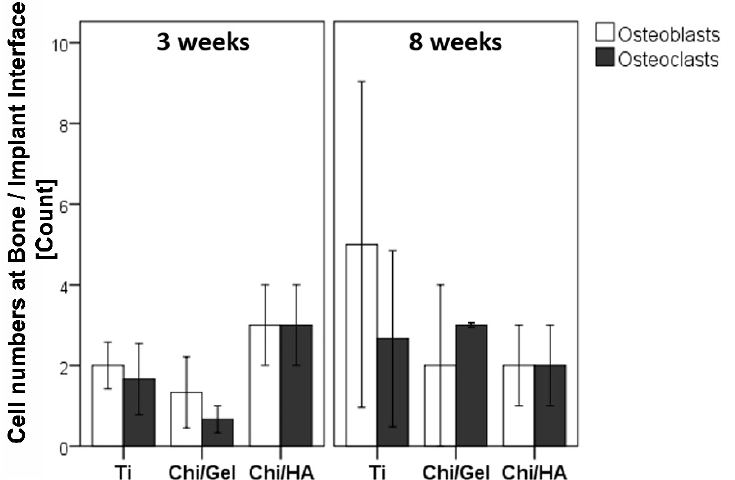
Figure 2. Quantitative evaluation of osteoblasts and osteoclasts within bone-implant interface showed higher osteoblasts/osteoclasts count in Ti and Chi/Gel groups after 8 W. Bone remodeling is governed by balanced osteoblast and osteoclast activity. Therefore, osteoblasts and osteoclasts were quantitatively evaluated for all groups. Higher osteoblasts and osteoclasts count were seen in Ti and Chi/Gel groups after 8 W compared with 3 W. Whereas, a lower number of osteoblasts and osteoclasts were seen in the Chi/HA group after 8 W compared with 3 W (Ti: n = 5 (3 W), n = 3 (8 W); Chi/Gel: n = 5/time point; Chi/HA: n = 4 (3 W), n = 5 (8 W).